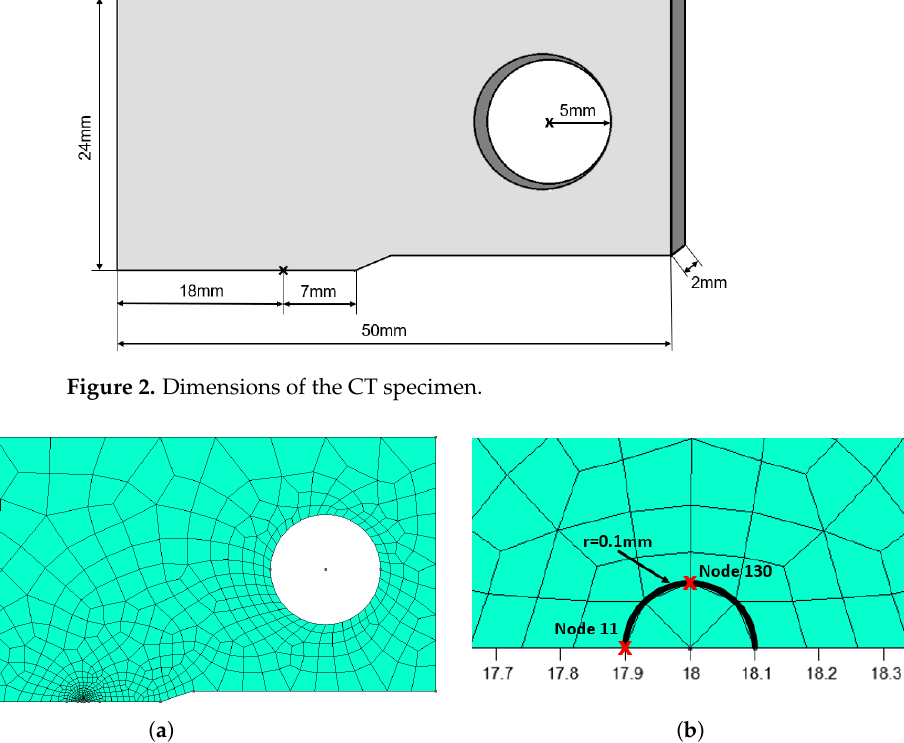
Figure 3. Mesh designed for the CT specimen. ( a ) Complete designed mesh. ( b ) Zoom in around the crack